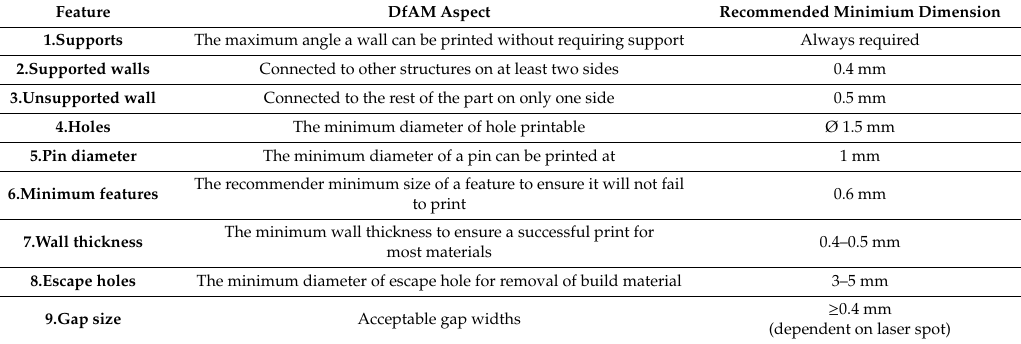
Table 1. Design rules based on geometrical features suitable for metallic laser PBF (L-PBF). Adapted from